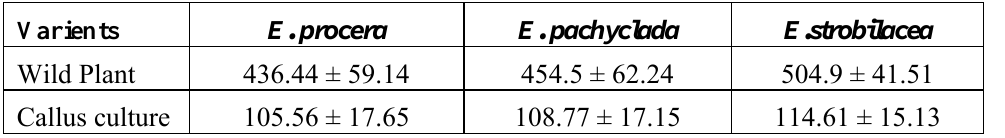
Table 4. Comparison of total phenol content in wild plant and callus culture of three Ephedra species based on the Folin Ciocalteau